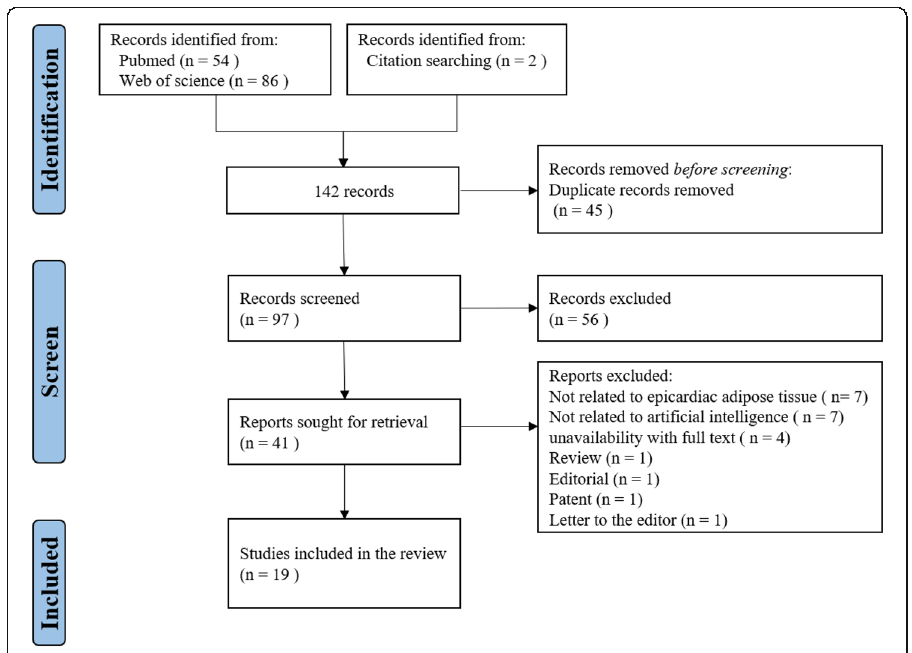
Fig. 1 Flow diagram for screening and selection of articles